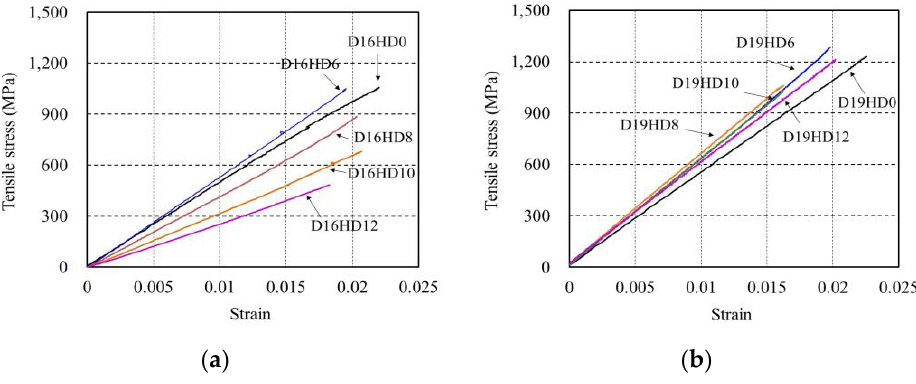
Figure 10. Tensile behavior of specimens: ( a ) D16; and ( b ) D19. Table 3. Tensile test results of plain and hollow GFRP rebar specimens.